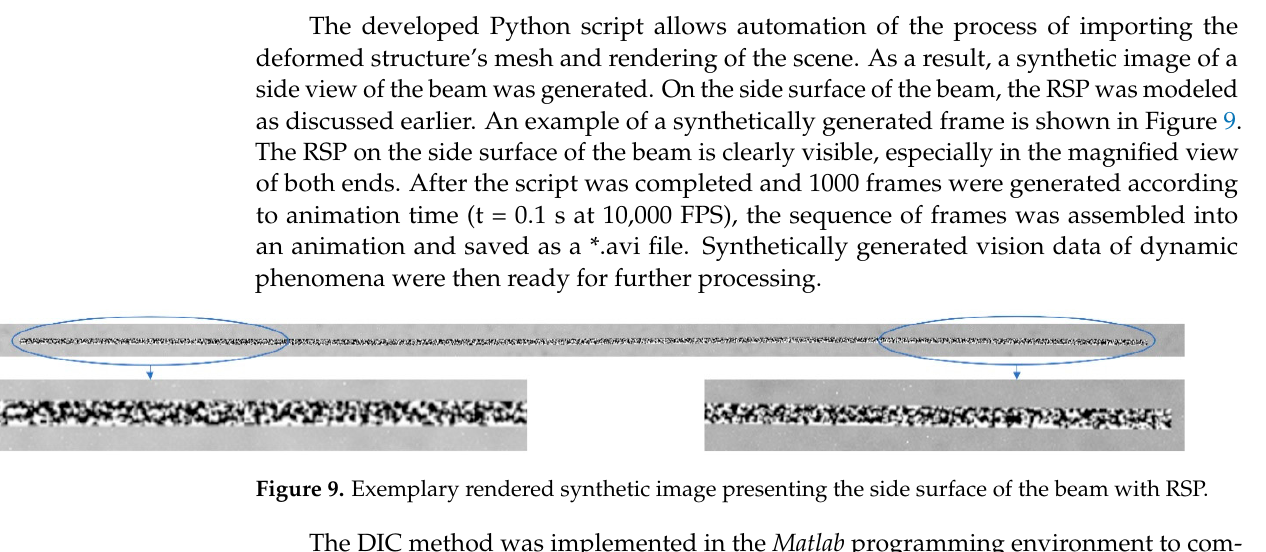
Figure 9. Exemplary rendered synthetic image presenting the side surface of the beam with RSP.